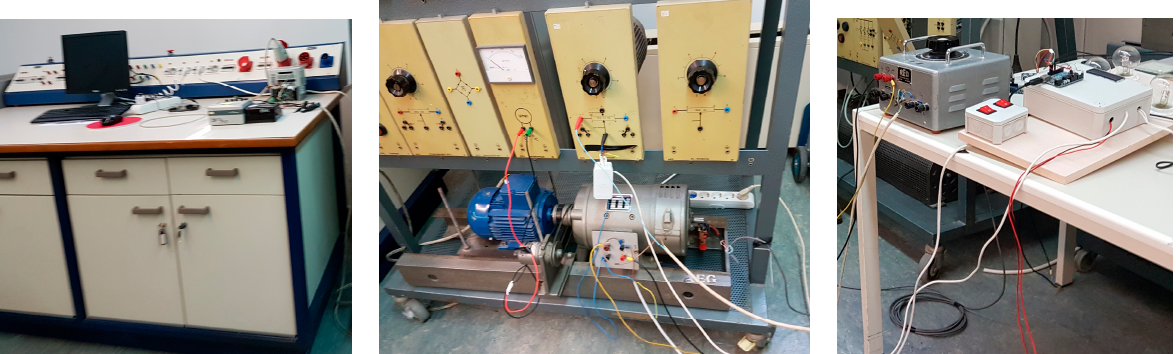
Figure 3. Experimental System (from left to right): Central control panel, SBC, monitor, keyboard, mouse, inverter, Induction Motor, dc generator, single-phase rectifier, speed optical encoder, SBM1, SBM2, optical isolation unit, electric load, measuring instrumentation.